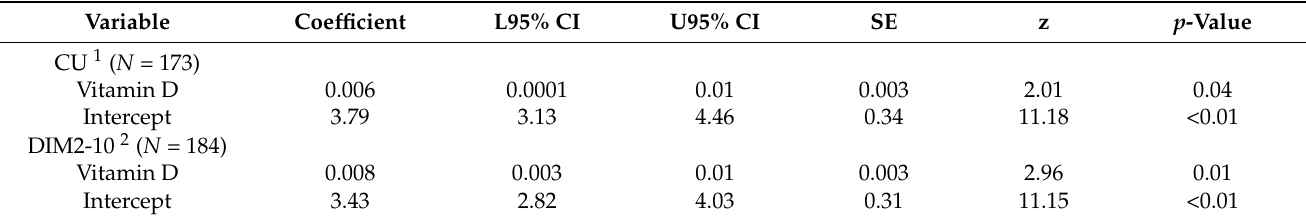
Table 4. Mixed linear regression results for the association of vitamin D with AOP at CU and